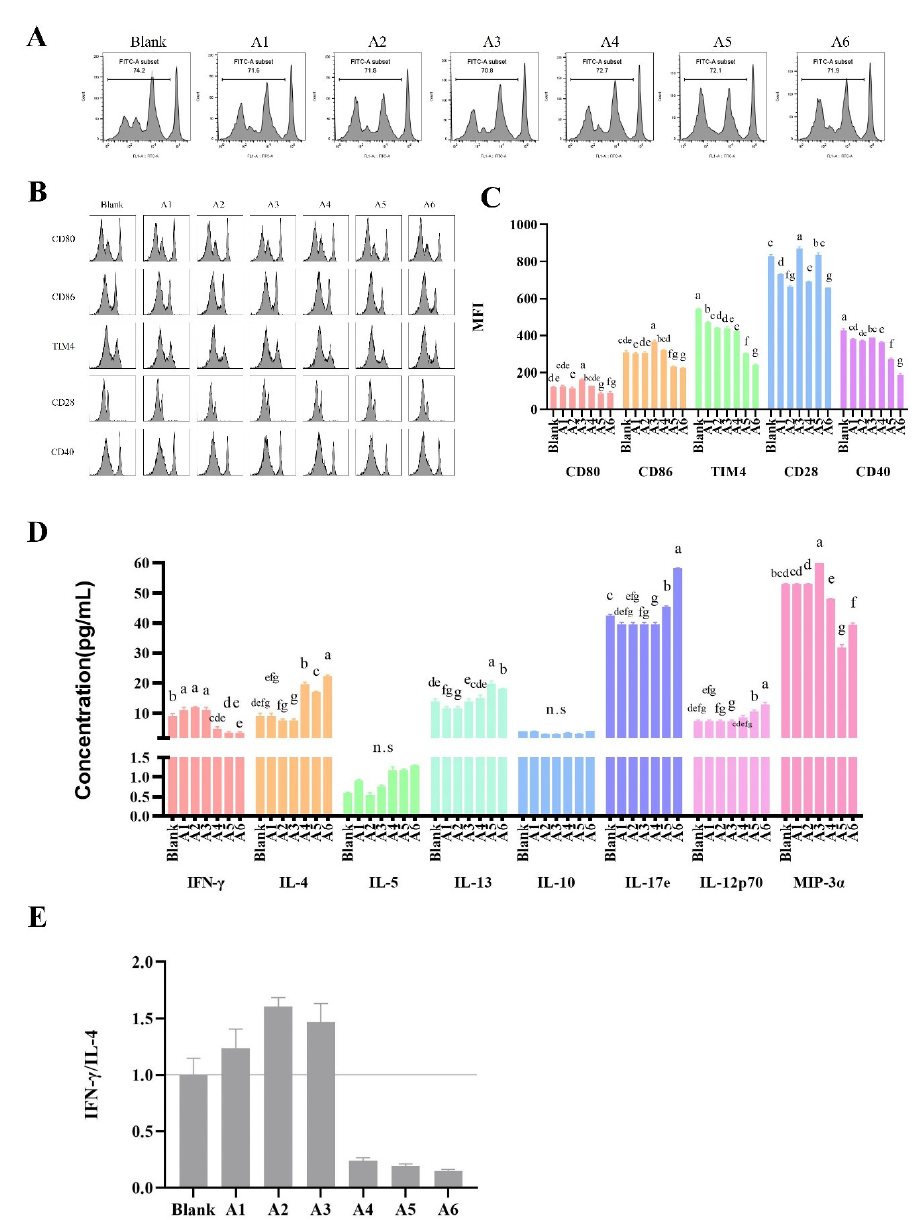
Figure 4. Peptide BLG 40–60 showing the promote maturation ability of LP cells and directed differ- entiation of activated CD4 + T lymphocytes towards a Th1 phenotype, but not the proliferation, in the peptide–LP cell–MLN cell-co-culture assay. ( A ) The intensity of CFSE staining after stimulation. ( B ) The histogram results of CD80, CD86, TIM-4, CD28, and CD40. Each row corresponds to a different gate result, and each column corresponds to a different peptide treatment group. ( C ) Bar graphs showing the MFI levels summarized from ( B ). ( D ) Bar graphs showing the cytokines levels of IFN- γ , IL-4, IL-5, IL-13, IL-10, IL-17e, IL-12p70, and MIP-3 α . ( E ) Bar graphs showing the IFN- γ /IL-4 ratio summarized from ( D ). The results are represented as the mean ± SD. (The data were calculated in three replicates for flow cytometry assay, and two replicates for cytokine level. The same letters indicate the lack of significance, as determined by two-way analysis of variance (ANOVA) with Duncan’s post-test ( p < 0.05).) LP cell, intestinal lamina propria cell. Th, T helper lymphocyte. MLN, mesenteric lymph node. CFSE, 5-(and 6)-carboxyfluorescein diacetate, succinimidyl ester. TIM-4, T cell immunoglobulin and mucin domain (TIM)-4. MFI, median fluorescence intensity. IFN- γ , interferon γ . IL,